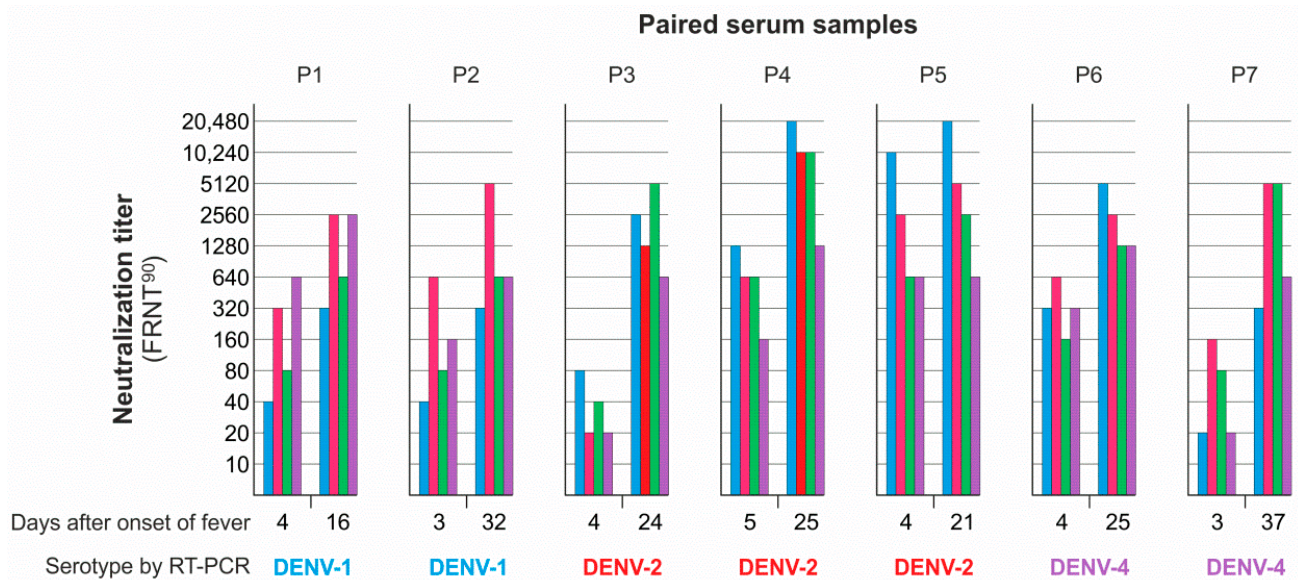
Figure 2. Neutralization of DENV-1–4 reference strains by paired serum samples. Sera were collected from Colombian patients infected by DENV-1, DENV-2, and DENV-4 as diagnosed by RT-PCR. Viruses (REF set) used for foci reduction neutralization test (FRNT 90 ): blue, DENV-1 (16007); red, DENV-2 (16881); green, DENV-3 (H87); purple, DENV-4 (H241).